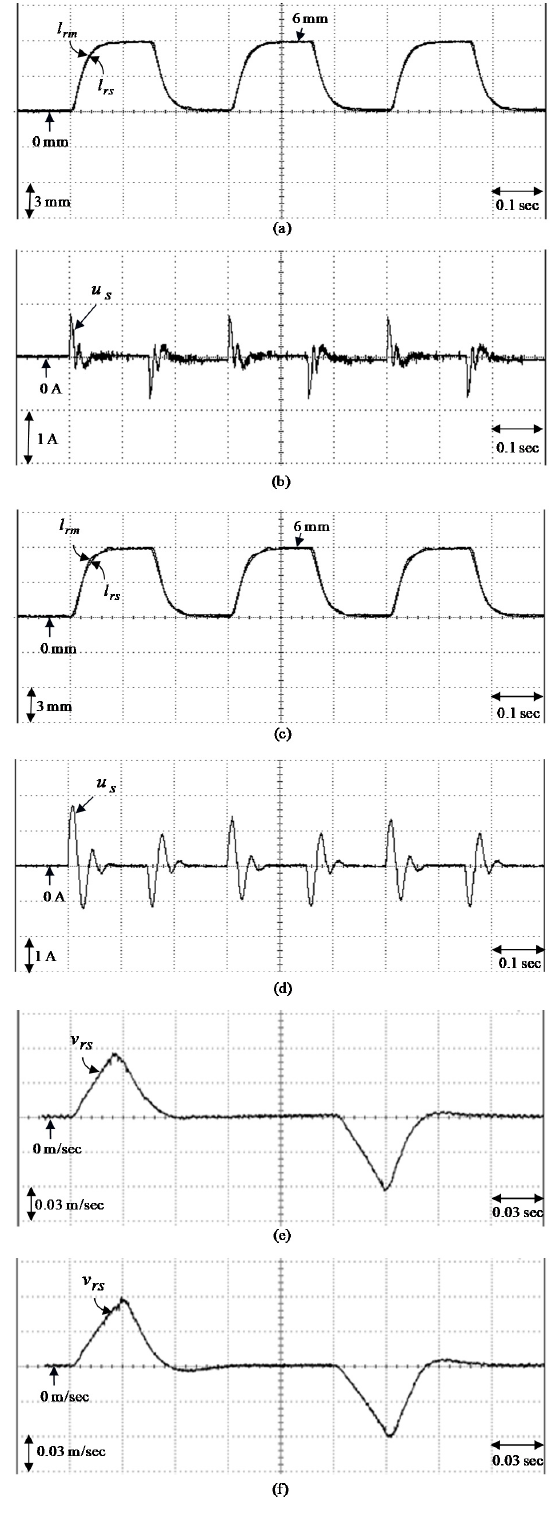
Figure 8. Tested results utilized by the control system K1: ( a ) mover position response at Situation Q1, ( b ) control propulsion response at Situation Q1, ( c ) mover position response at Situation Q2, ( d ) control propulsion response at Situation Q2, ( e ) mover velocity response at Situation Q1, ( f ) mover velocity response at Situation Q2.